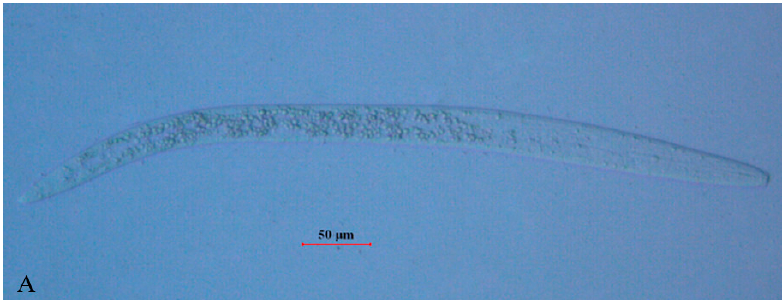
Figure 1. Cont. Figure 1.